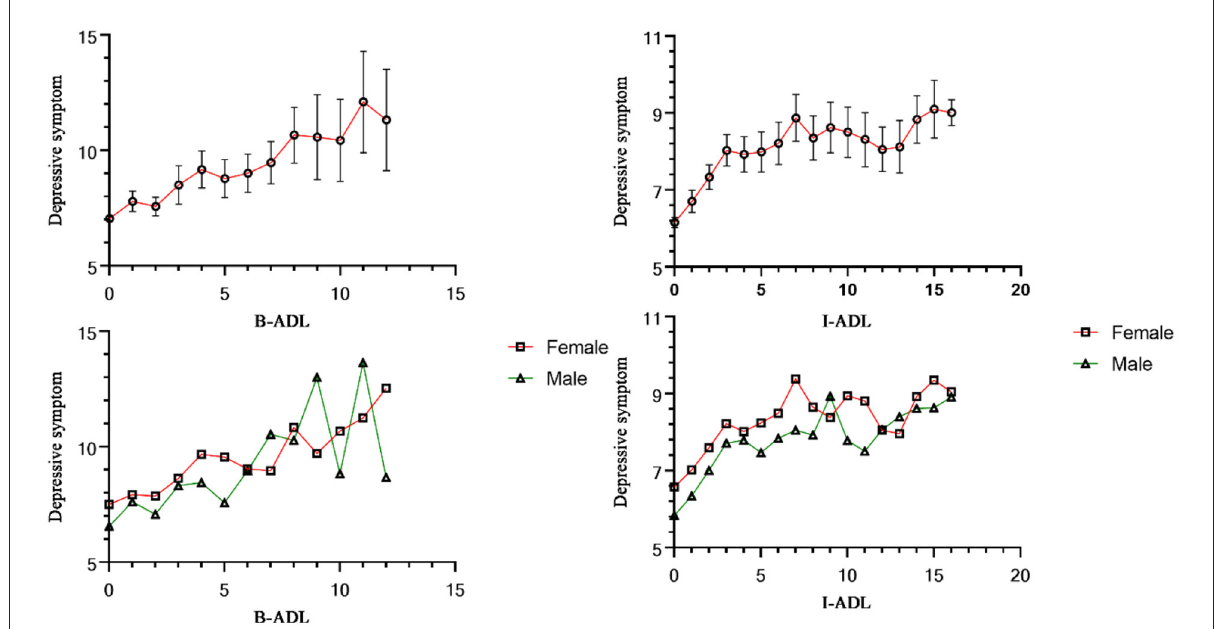
FIGURE1 Association between disability and depressive symptoms in the elderly.